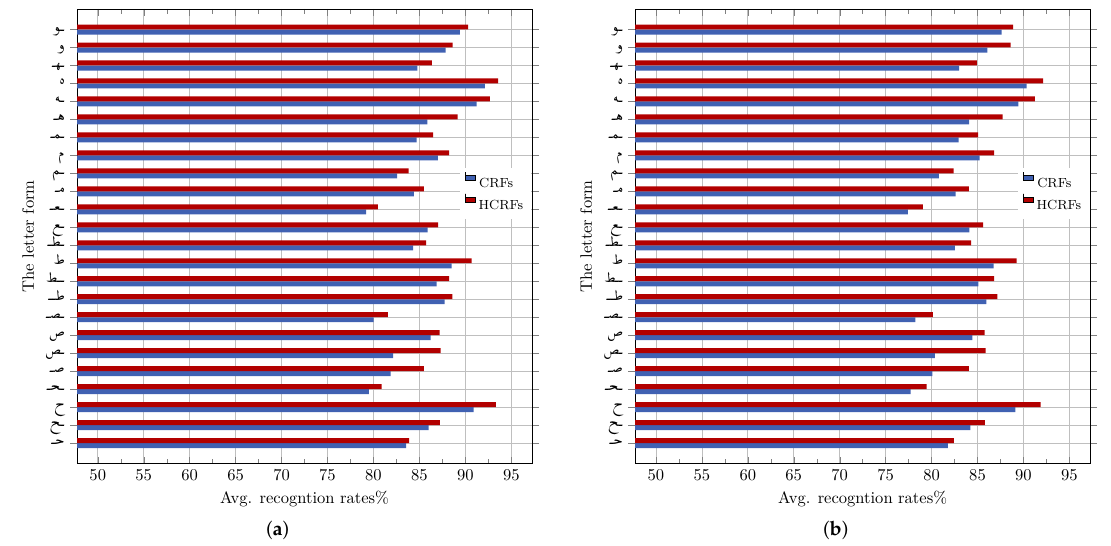
Figure 8. CRF and HCRF performance on letter shapes under node Tax.2: ( a ) performance on samples drawn from the IESK-arDB database; and ( b ) performance on samples drawn from the IFN-ENIT database.